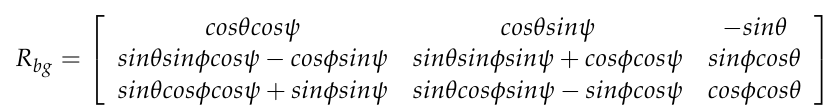
Figure 4. Relationship between the ground coordinate system and the airframe coordinate system.